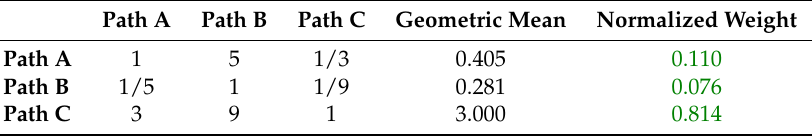
Table 5. Weight Evaluation for ‘Crowd’.